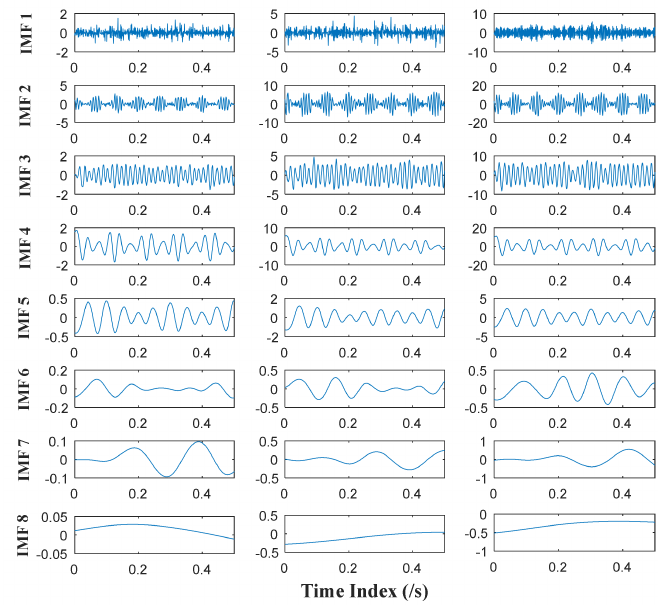
Figure 9. Time domain plots of IMFs of